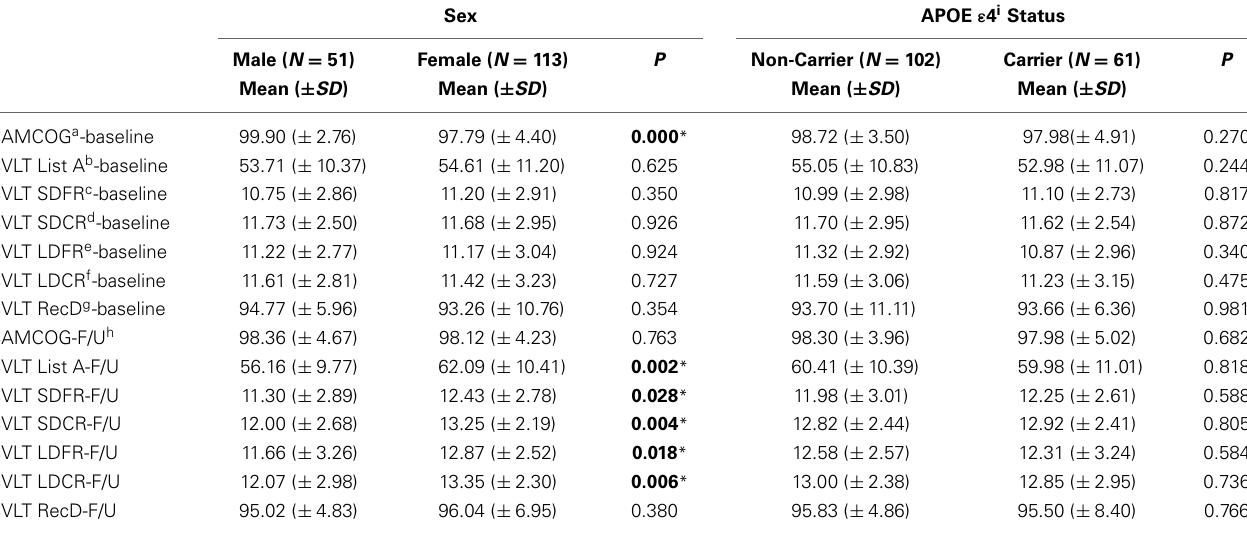
Table 2 | Descriptive cognitive data including p -values corresponding to independent t †